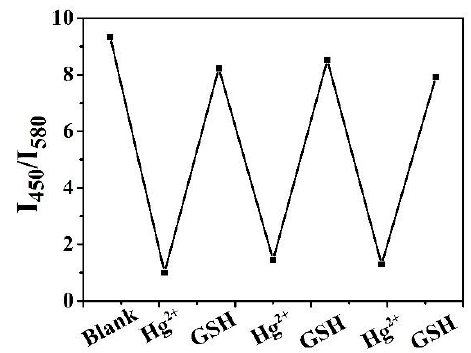
( f ) Figure 8. ( a – c ) Fluorescence spectra change of dual-emission silica microspheres upon adding